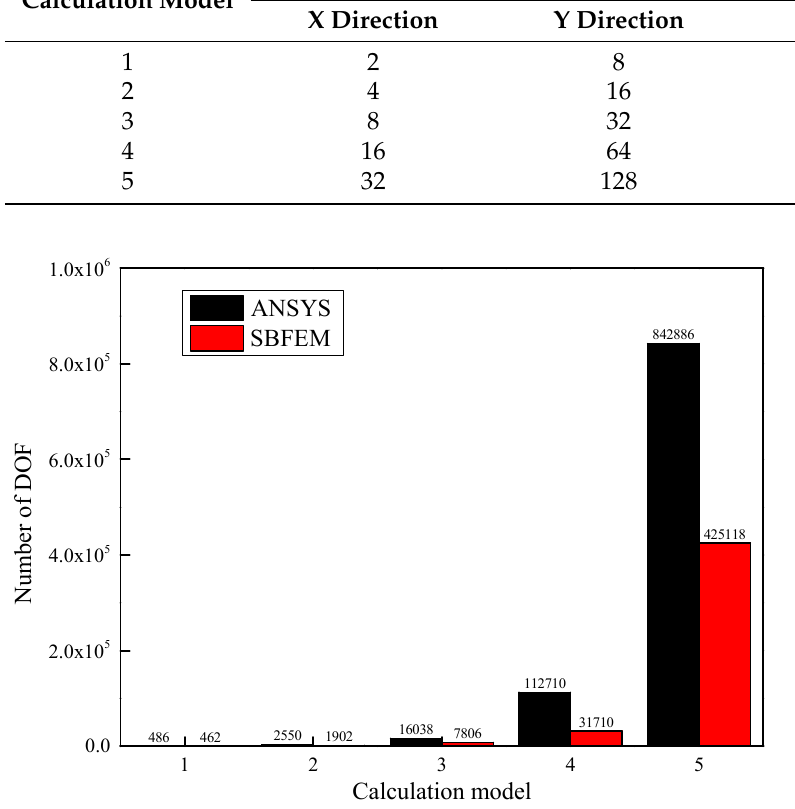
Figure 4. Number of DOF vs. calculation model.